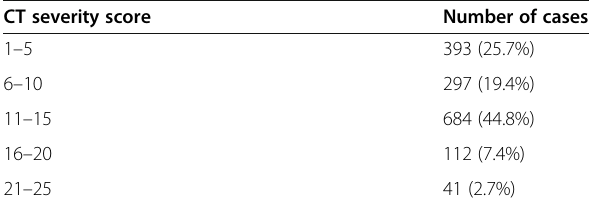
Table 3 The CT-SS value and the corresponding number of patients with COVID-19 pneumonia